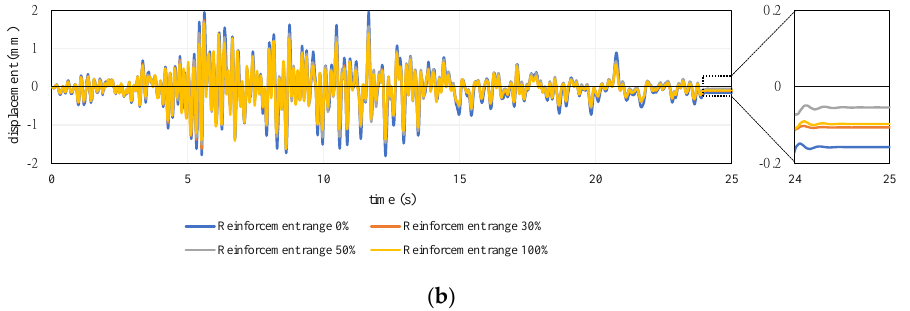
Figure 23. Comparison of displacement−time history at the top of the pier in TYPE-C: ( a ) under wave A; ( b ) under wave B.